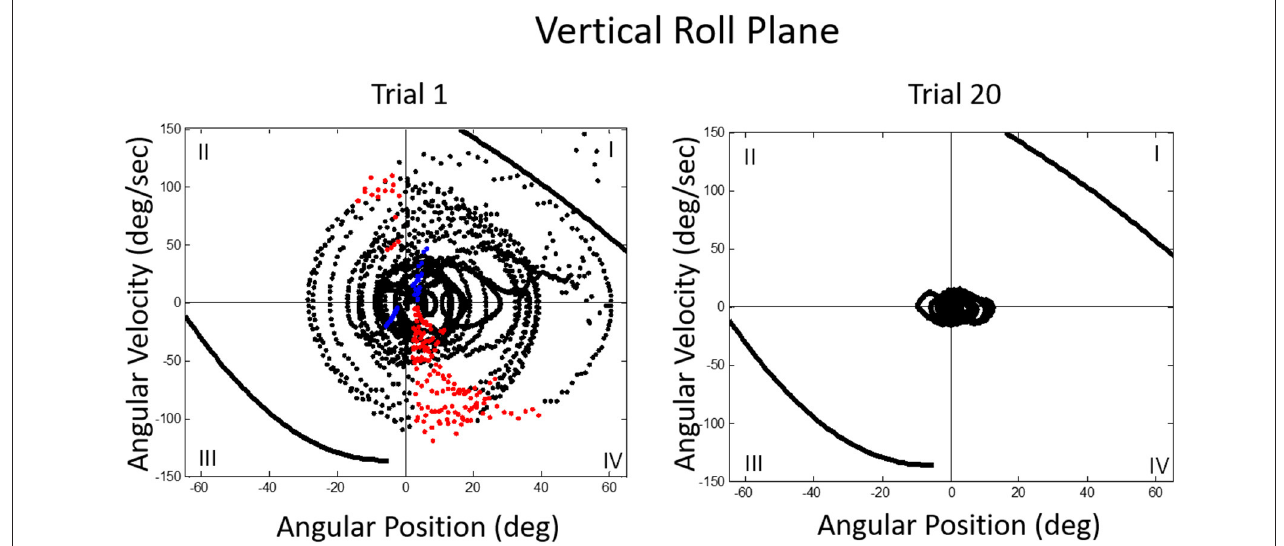
FIGURE 11 | Velocity-position phase plots for a typical subject in vertical roll plane balancing. Solid lines in quadrants 1 and 3 represent crash boundaries where joystick commands cannot prevent the MARS from exceeding + or − 60 degrees. Dots outside these lines represent crashes. The MARS is reset to the start position after a crash and the trial then continues. Performance is near perfect after 20 trials. The red dots represent anticipatory joystick commands that slow the MARS down as it approaches the balance point. Blue dots represent destabilizing joystick commands that accelerate the MARS in the direction of a crash boundary.